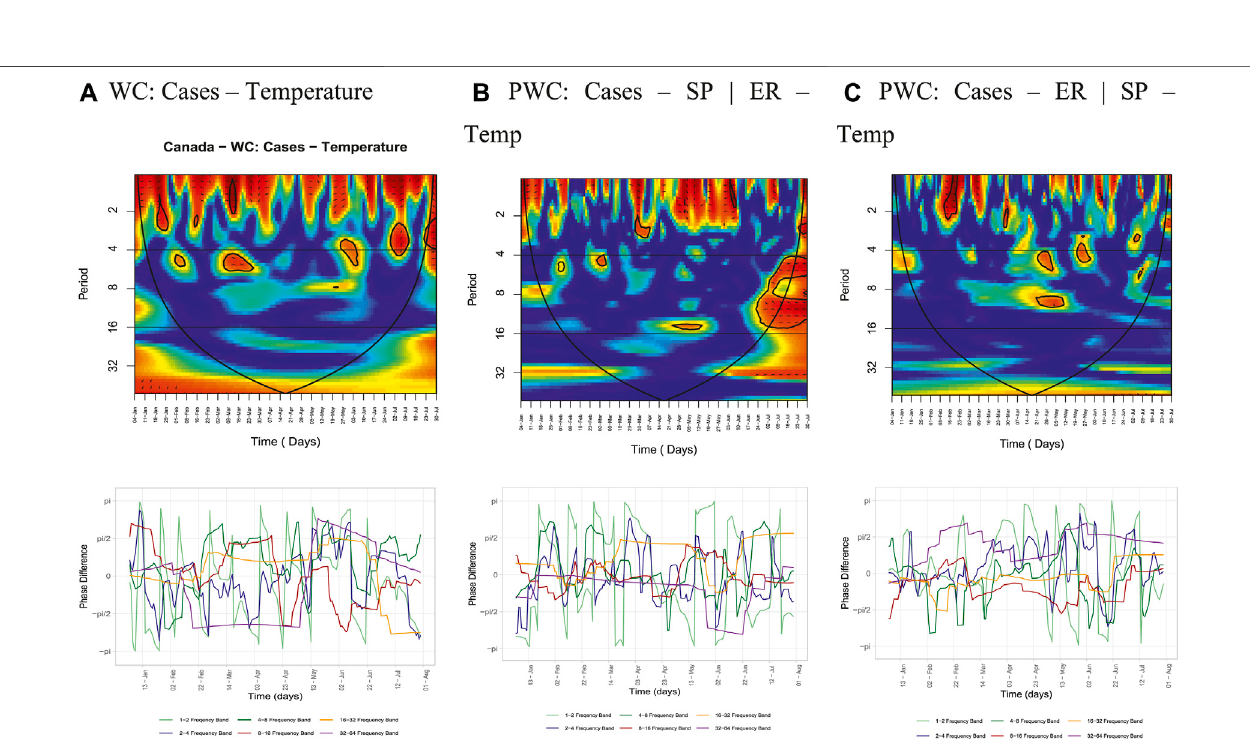
Frontiers in Environmental Science |